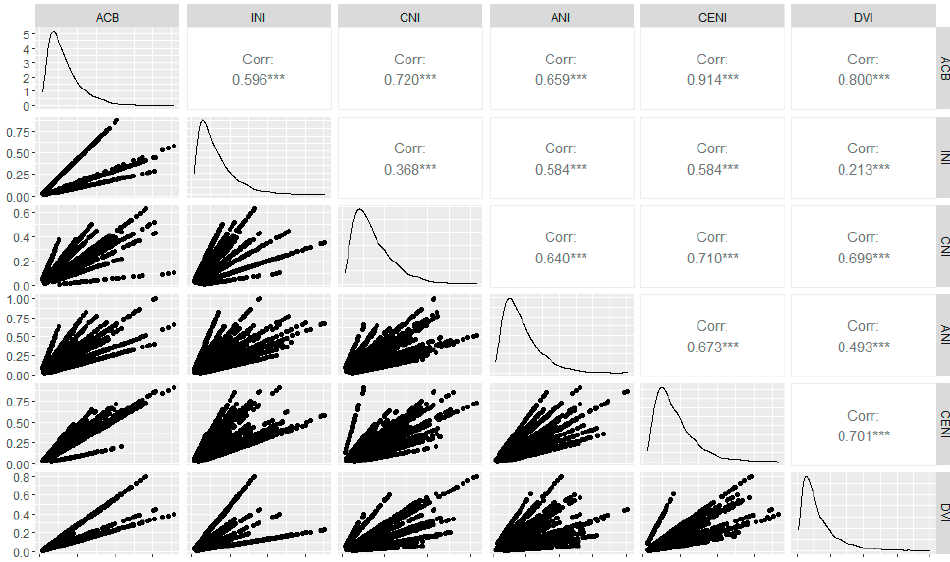
Figure 8. Correlation matrix between RPF factors and Composite Index of Online Purchasing Behavior as of December 2020. Source: developed by the authors. *** p ≤ 0.001.